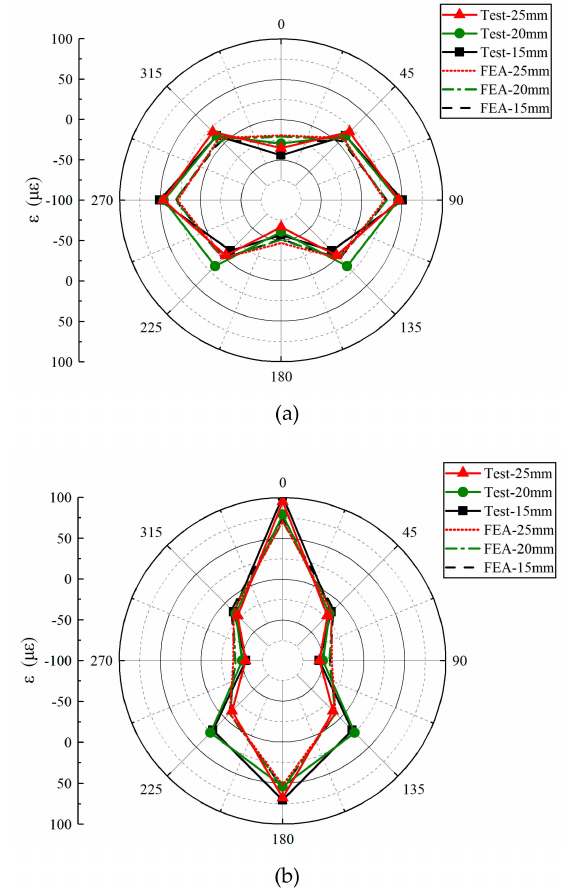
Figure 21. Circumferential strain curve of the pipes containing cracks with di ff erent depths: (a) outer wall and (b) inner